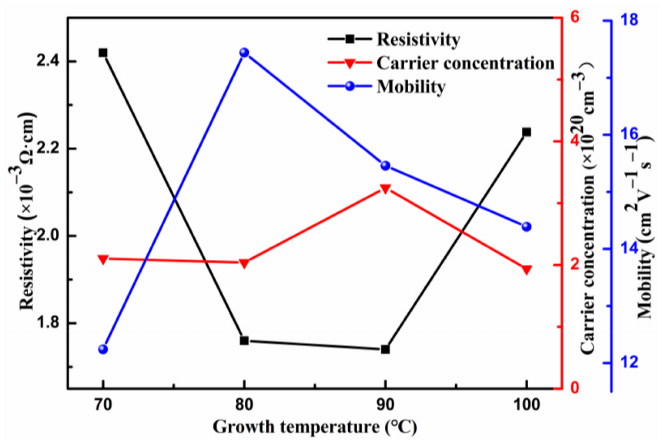
Figure 5. Electrical properties of the AZO films prepared at various growth